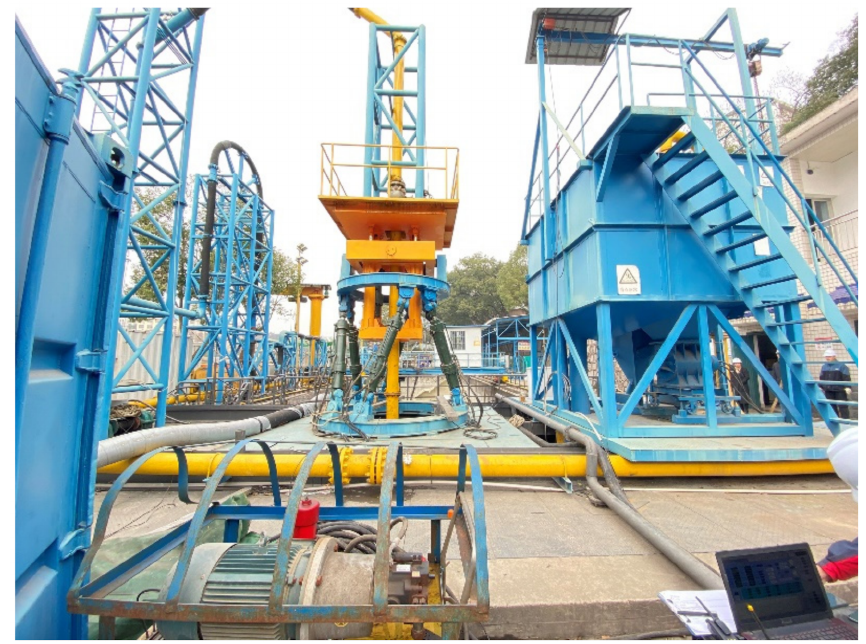
Figure 8. Experimental system site.